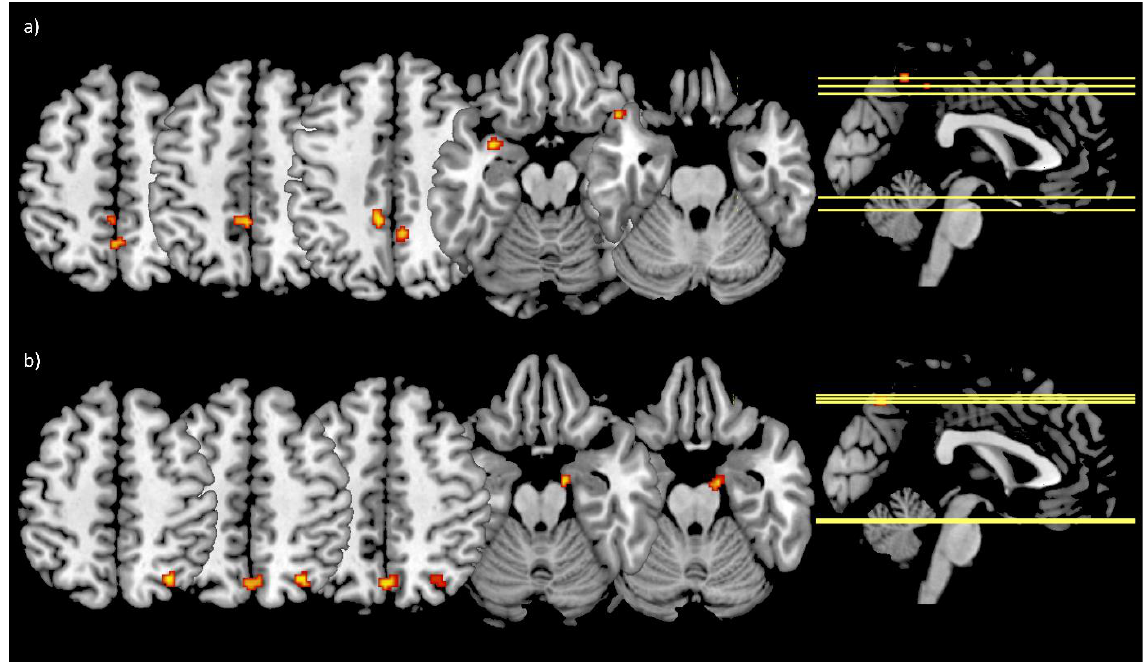
Figure 3. Main effects of the LME model for the bilateral amygdala FC changes. ( a ) Showing the clusters (red-yellow) derived from the time by group interaction within the left middle cingulate cortex, the precuneus, and the left temporal pole; ( b ) shows the clusters (red-yellow) from the main effect of time within the precuneus, the right superior parietal lobule, and the right parahippocampal gyrus; threshold: p < 0.001 uncorrected, k ≥ 10 voxels; IG: N = 18 ( N = 16 at T6), CG: N = 10.